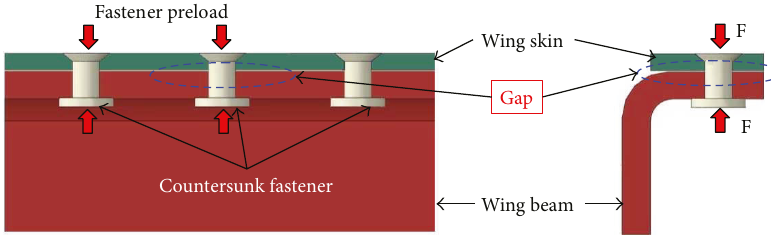
Figure 1: Load condition of wing skin and rib connection structure.